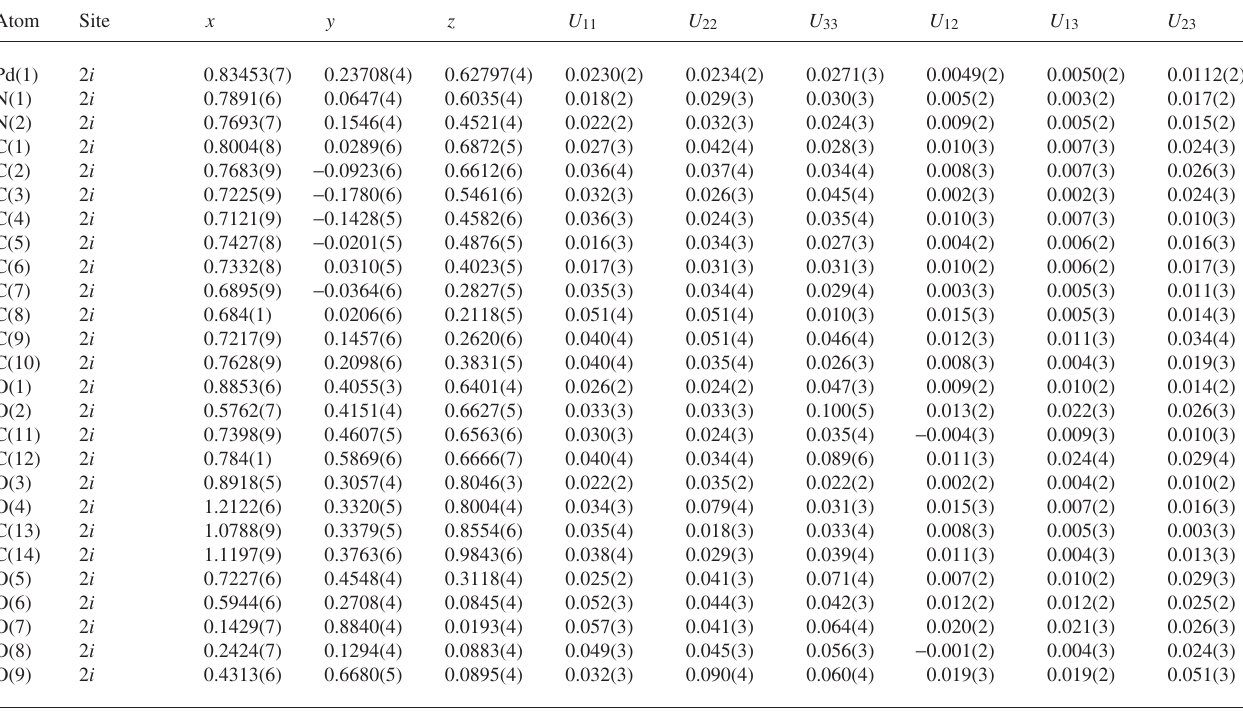
Table 3. Atomic coordinates and displacement parameters (in Å 2 ) .